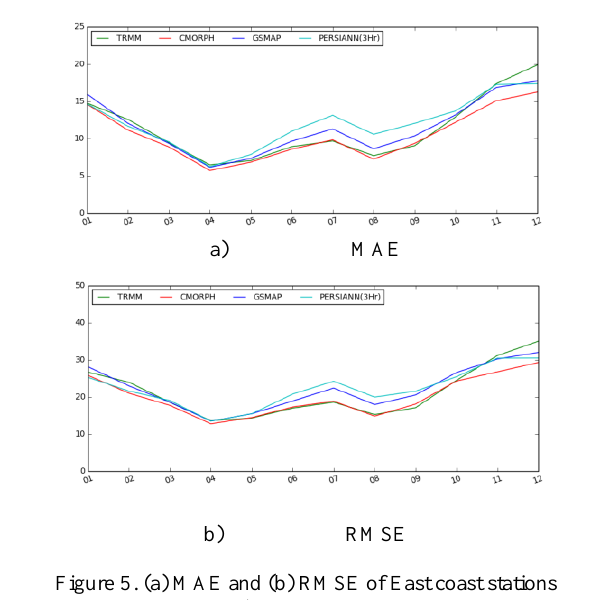
Figure 5. (a) MAE and (b) RMSE of East coast stations